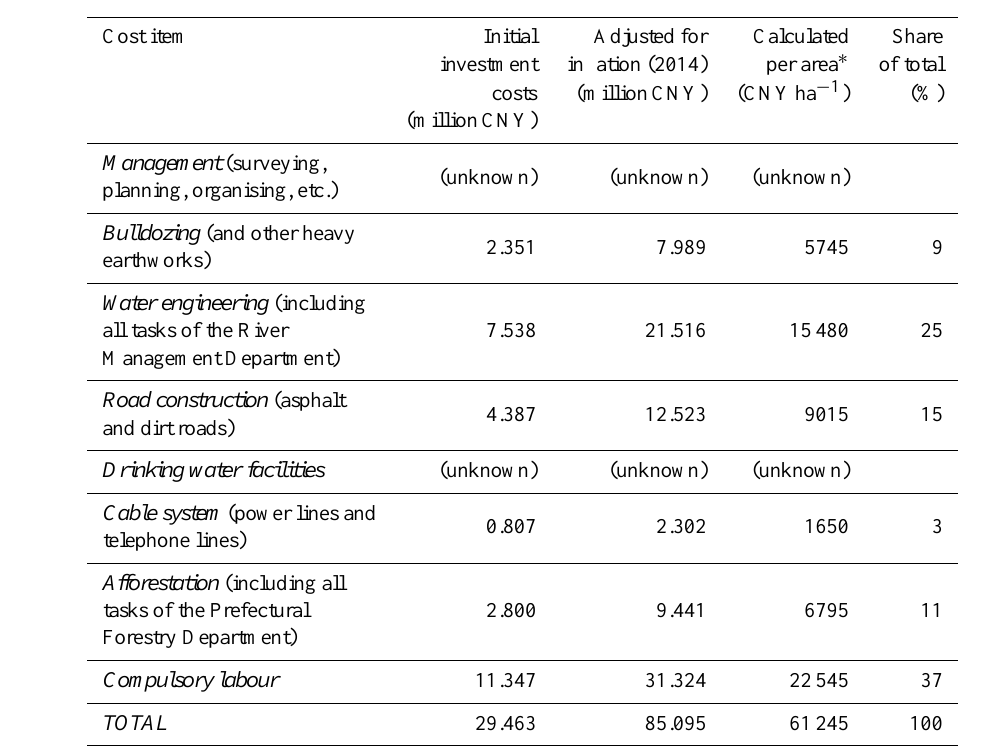
Table 2. The establishment costs of Kökyar I.